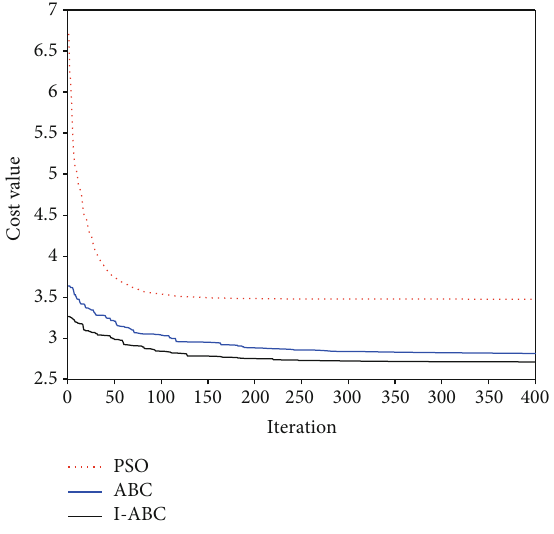
Figure 19: The evolution curves of three algorithms.